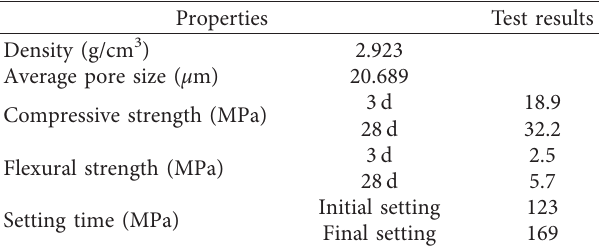
Table 1: Properties of composite Portland cement.